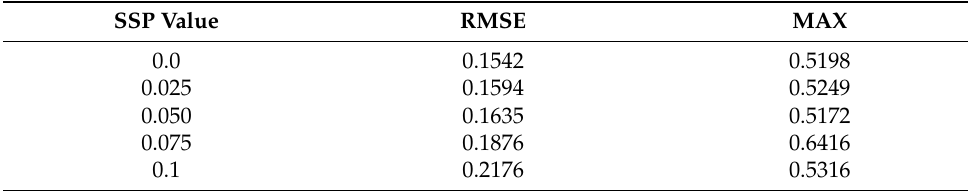
Table 2. Results of accuracy according to variation of SSP in Ackley’s path function.